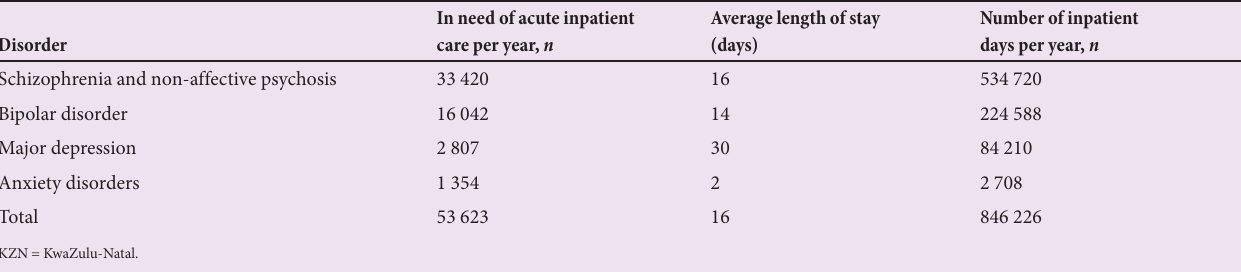
Table 3. Expected number of acute inpatient days in one year in KZN